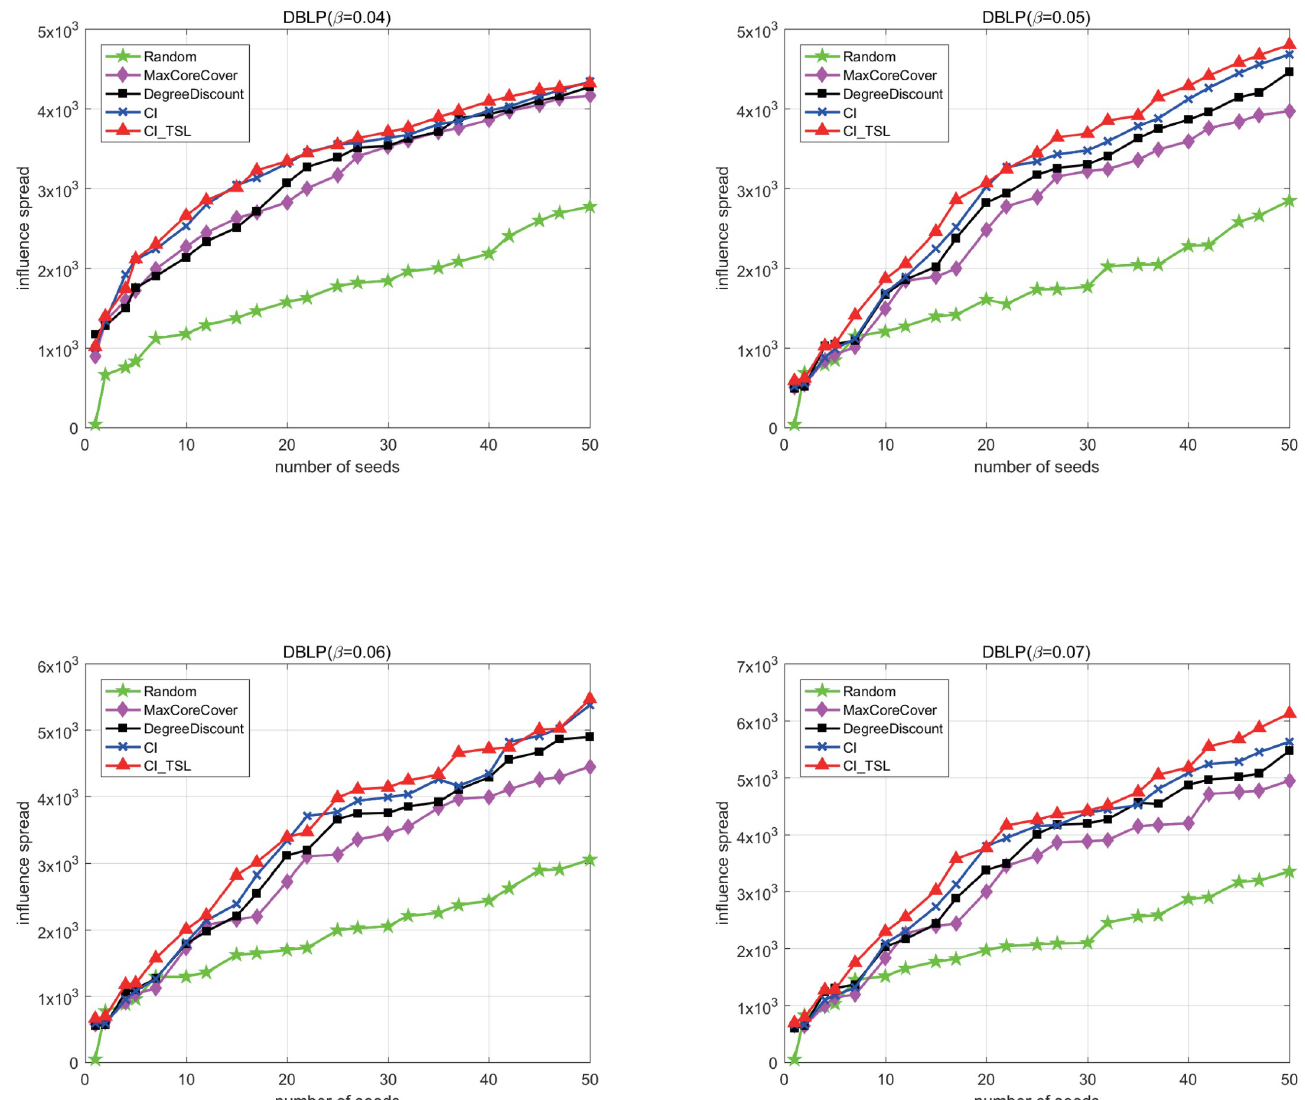
Fig 6. The spreading influence of different algorithms on the DBLP based on ICM with different β values.